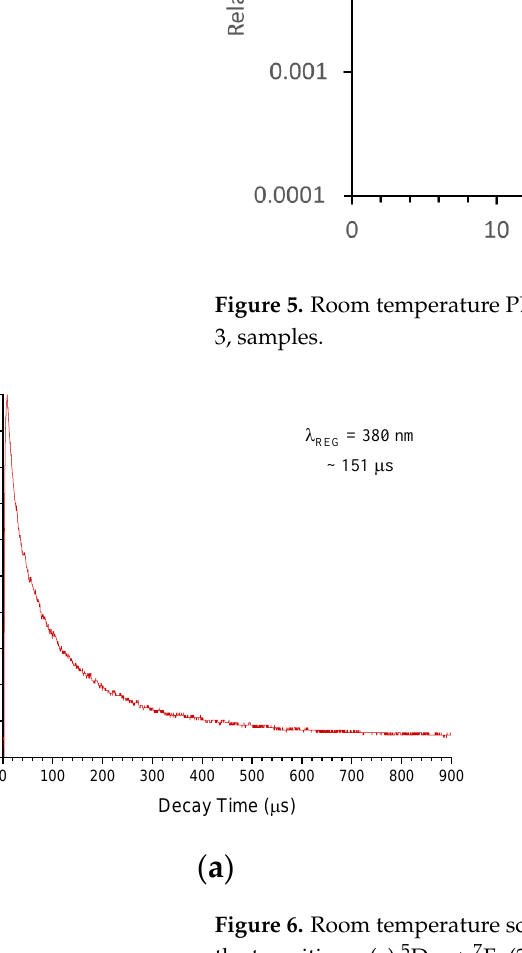
Figure 5. Room temperature PL kinetics 5 D 4 → 7 F J (λreg = 546 nm) in GYAGG:Tb- 2 и GYAGG:Tb -3, samples.